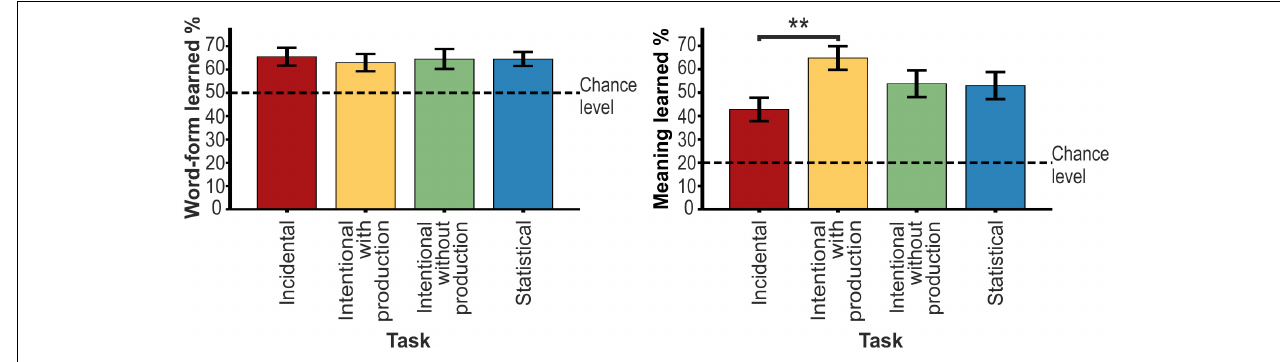
FIGURE 2 | The mean scores and the SEM for learned word-forms and meanings for four different tasks. The significant difference is marked with asterisks. Chance level is determined by the number of response options.